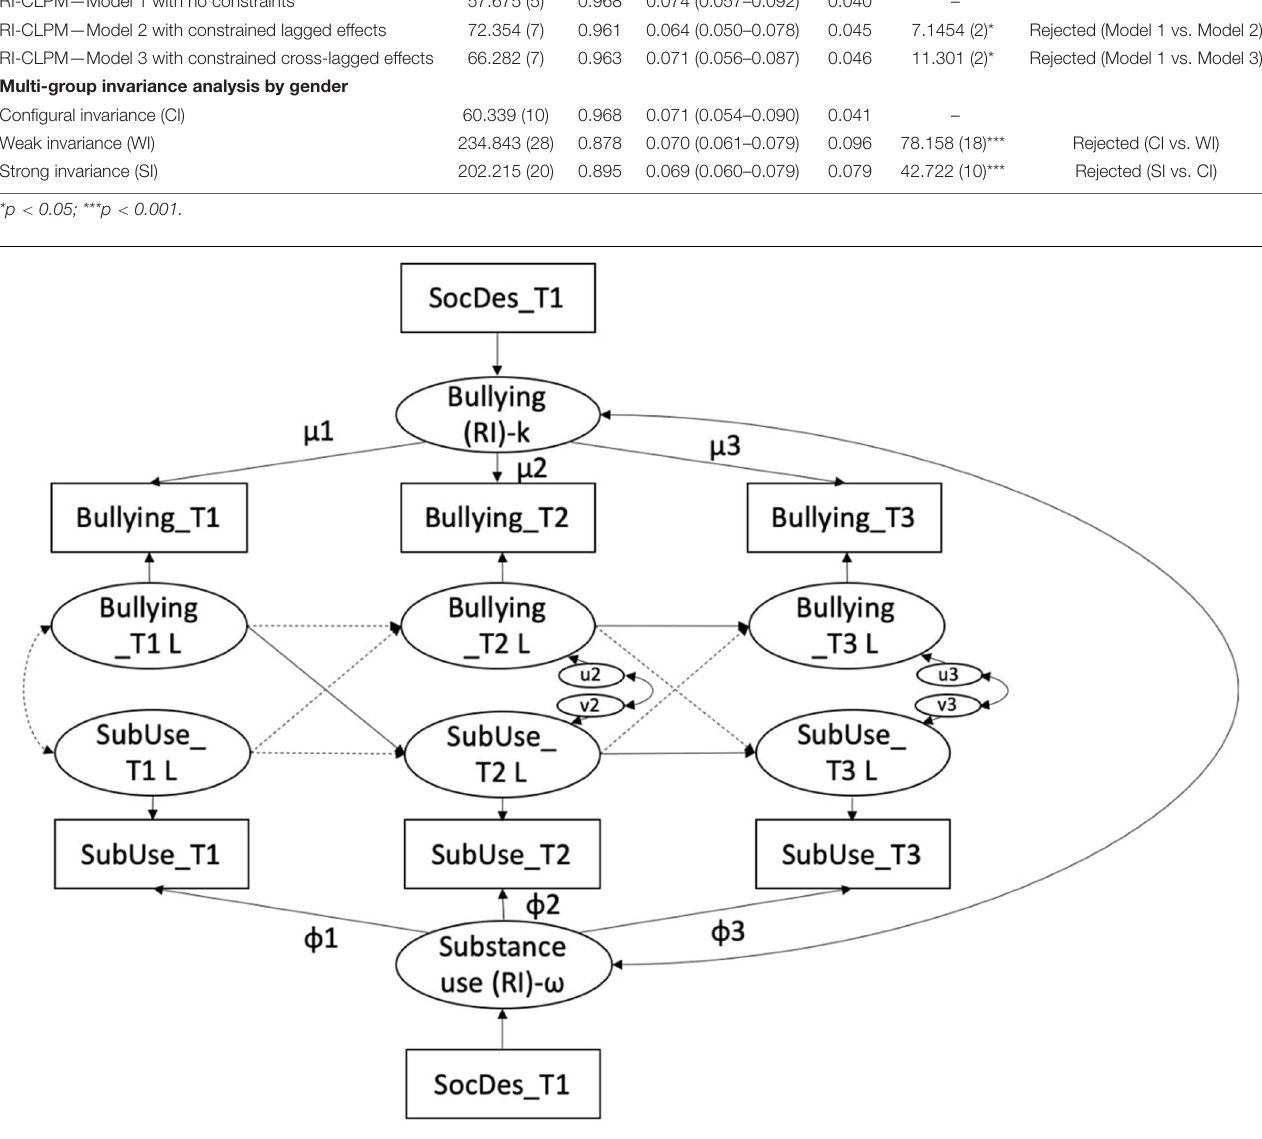
FIGURE 1 | Path diagram of the final unconstrained RI-CLP model. All factor loadings are constrained to 1. RI, Random Intercept; k, Kappa; ω , Omega; µ , mu; ϕ , phi; L-suffix, Latent factor of the indicator; SubUse, Substance Use; SocDes, Social Desirability. Plain arrows indicate significant paths; dotted arrows indicate non-significant